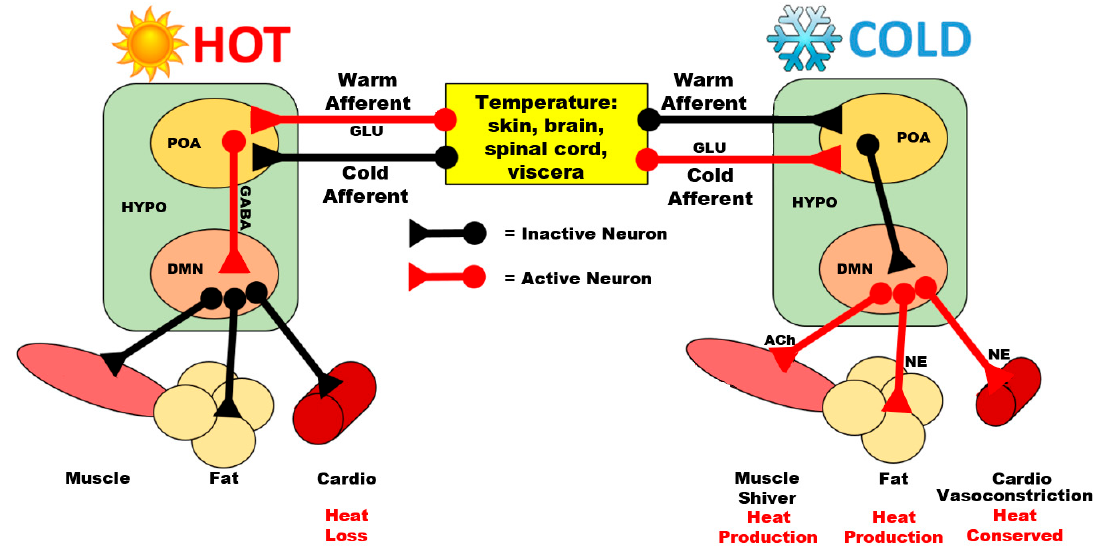
Figure 1. Simplified representation of the mammalian thermoregulatory system. Temperature receptors in various regions relay information to the preoptic area (POA) of the hypothalamus through the release of glutamate (GLU) from warm or cold afferents. For high temperature, the POA inhibits the dorsomedial nucleus of the hypothalamus (DMN) through gamma-aminobutyric acid (GABA) release. This results in the inactivation of circuits to the muscle, fat, and cardiovascular system, thereby reducing heat producing activities and increasing heat loss. For cooler temperatures, POA inhibition of the DMN decreases, which causes increased outflow from the DMN to peripheral targets, resulting in shivering through skeletal muscles, mediated by acetylcholine (ACh) release, increased heat production from fat metabolism due to increased norepinephrine (NE) release, and vasoconstriction to conserve heat. Adapted from [56] .